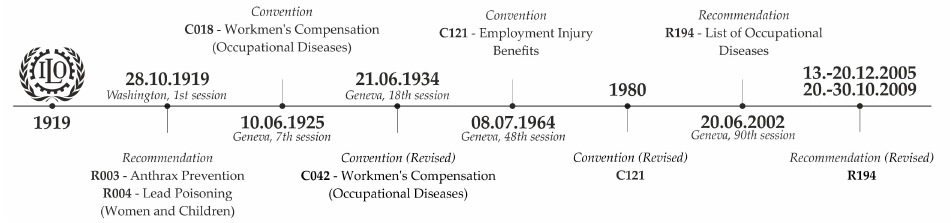
Figure 4. ILO Timeline [Source: